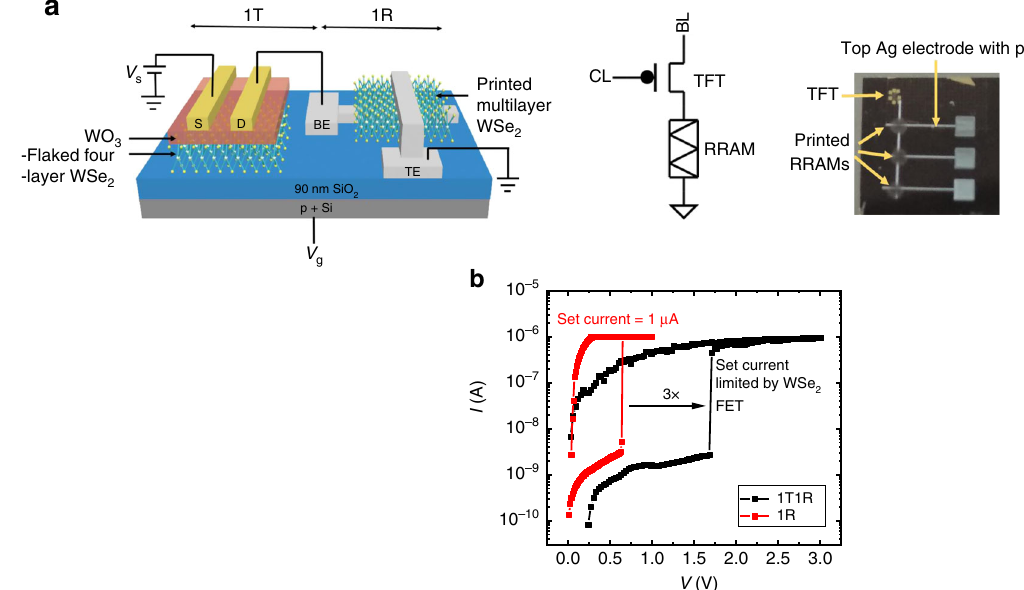
Fig. 4 1T1R con fi guration and characterization. a 3D schematic view of 1T1R structure with fl aked WSe 2 transistor and printed WSe 2 ReRAM and the corresponding circuit representation. The photo image of 3× WSe 2 ReRAMs printed using low-temperature aerosol jet printing method, which is linked up to the fabricated WSe 2 TFT on a single chip is also shown. b I – V switching plot for 1T1R con fi guration, where the switching current is limited by